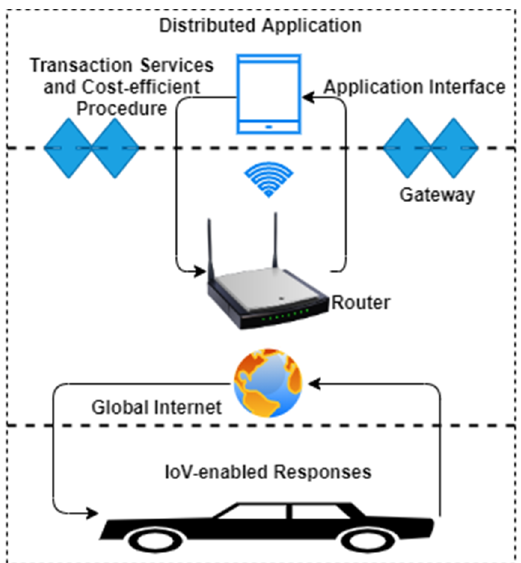
Figure 1. Current working Applicational Interface for IoV.